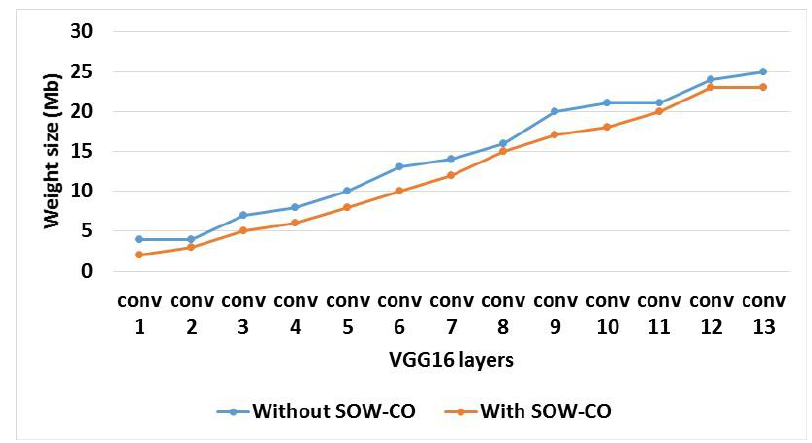
Figure 12. Graphical illustration of weight size for VGG16.